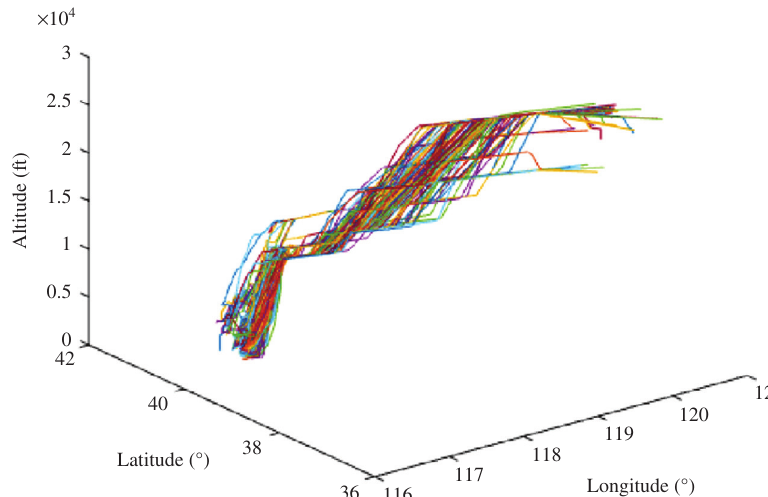
Figure 4: Three-Dimensional Display of Trajectory